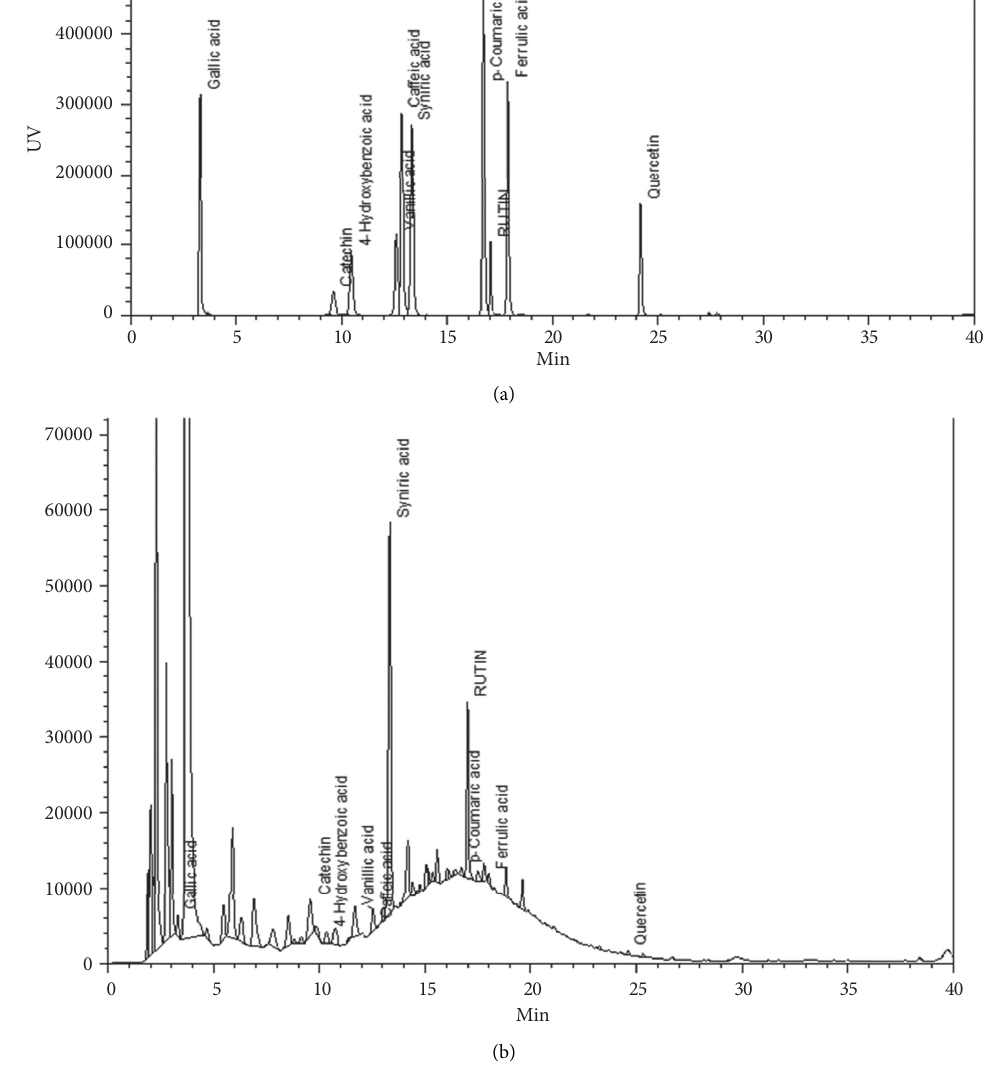
Figure 3: HPLC chromatograms of (a) mixed phenolic standards and (b) avocado seed extract recorded at 280nm.